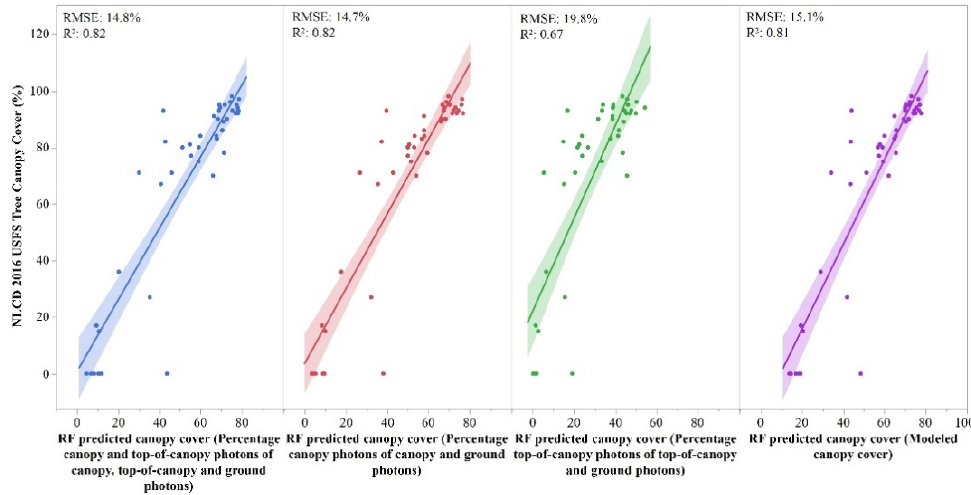
Figure 4. NLCD tree canopy cover versus RF-predicted canopy cover for SHNF.